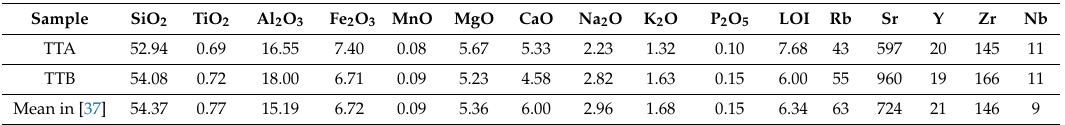
Table 1. Chemical composition of TTA and TTB samples and the mean of chemical composition of the volcaniclastic sandstones reported in [37]. Trace elements are expressed in